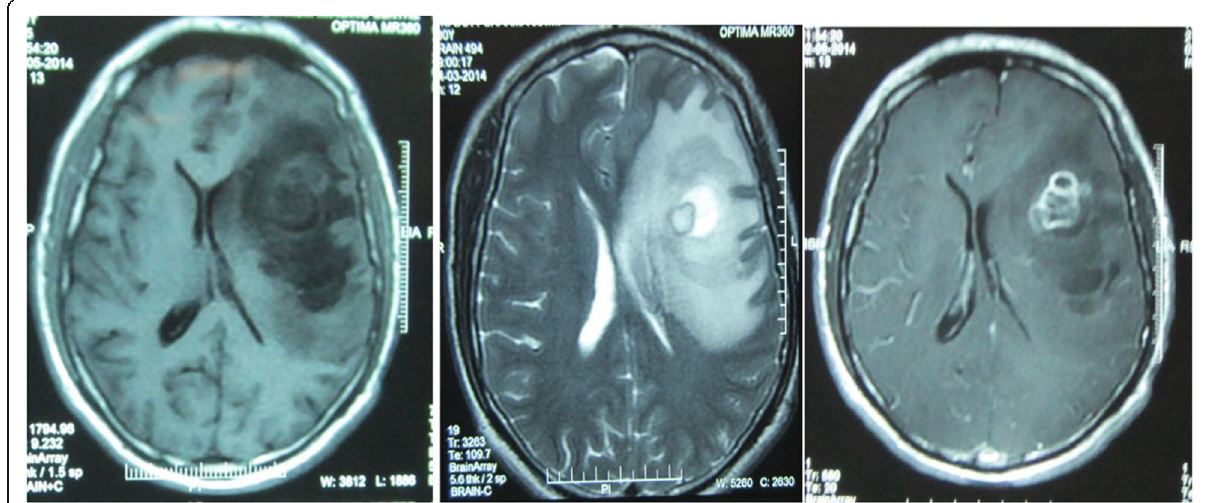
Fig. 2 Magnetic resonance imaging showing left T1WI large hypointense area with effacement of ventricle and middle T2WI showing central small hyperintense area with surrounding hypointense ring and with hyperintense gross oedematous area around right contrast study showing ring-enhancing lesion with central